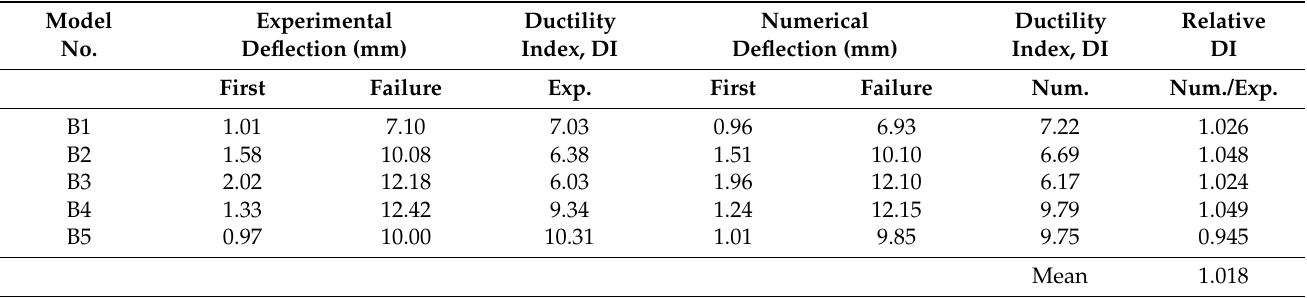
Table 6. Comparison of the experimental and numerical results of the ductility indexes based on the mid-span deflections of the RC beam